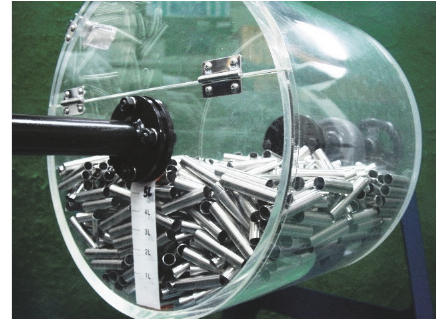
Figure 12: Hull volume in an acryl reactor (the volume is indicated byliter(L)ontheordinateaxis,weight=20 kg,andlength=50 mm).